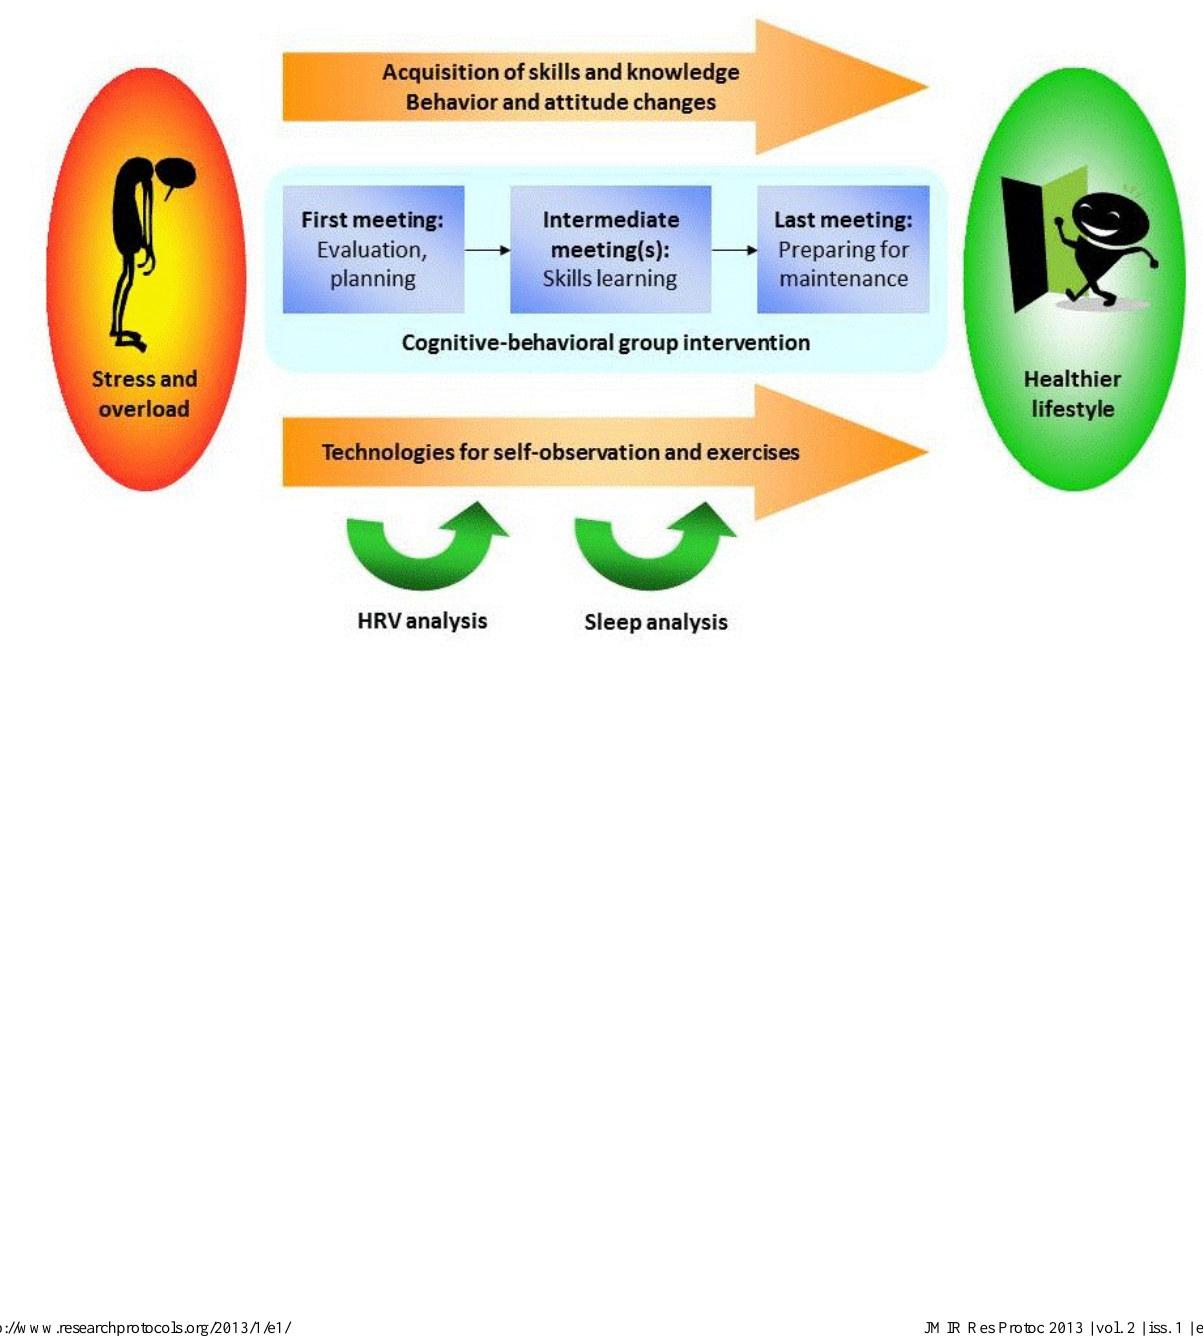
Figure 2. P4well intervention